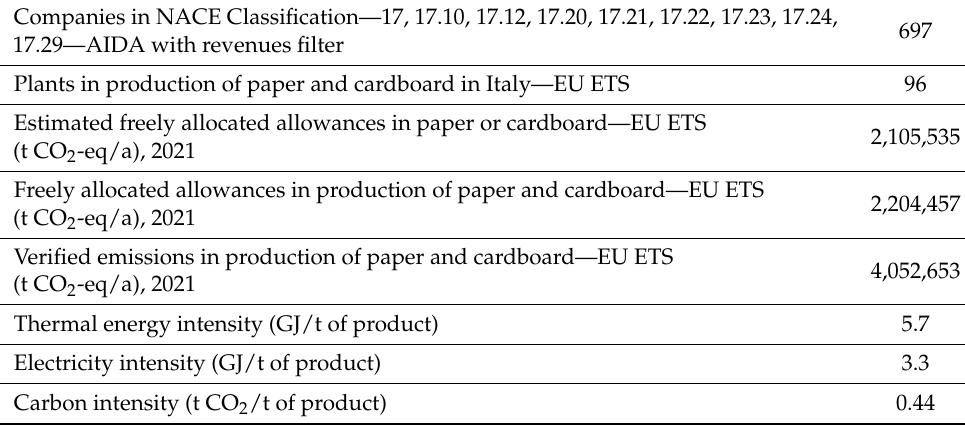
Table 8. Summary data for paper production plants in Italy under EU